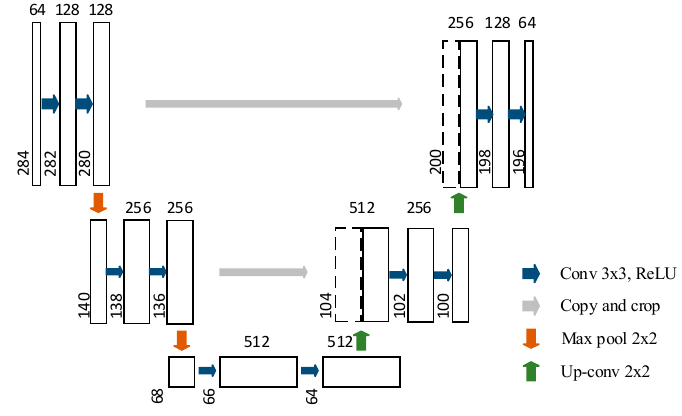
Figure 2. U-Net block. The U-Net consists of a contracting path and an expanding path. The horizontal connection combines the features of the upsampling and downsampling processes.